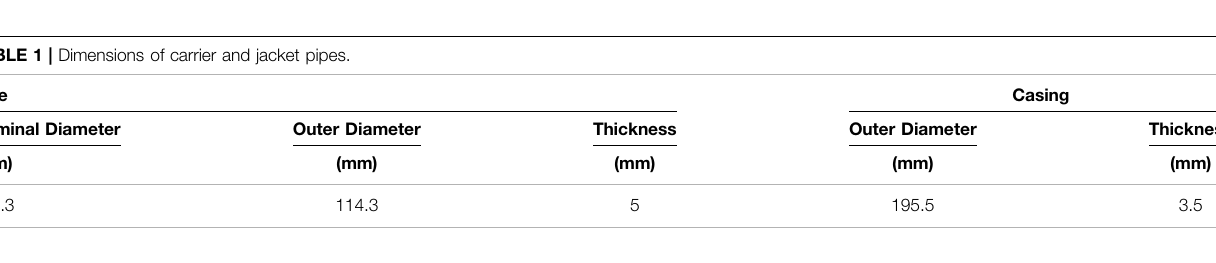
TABLE 2 | Characteristics of Heat carrying medium and pipe.